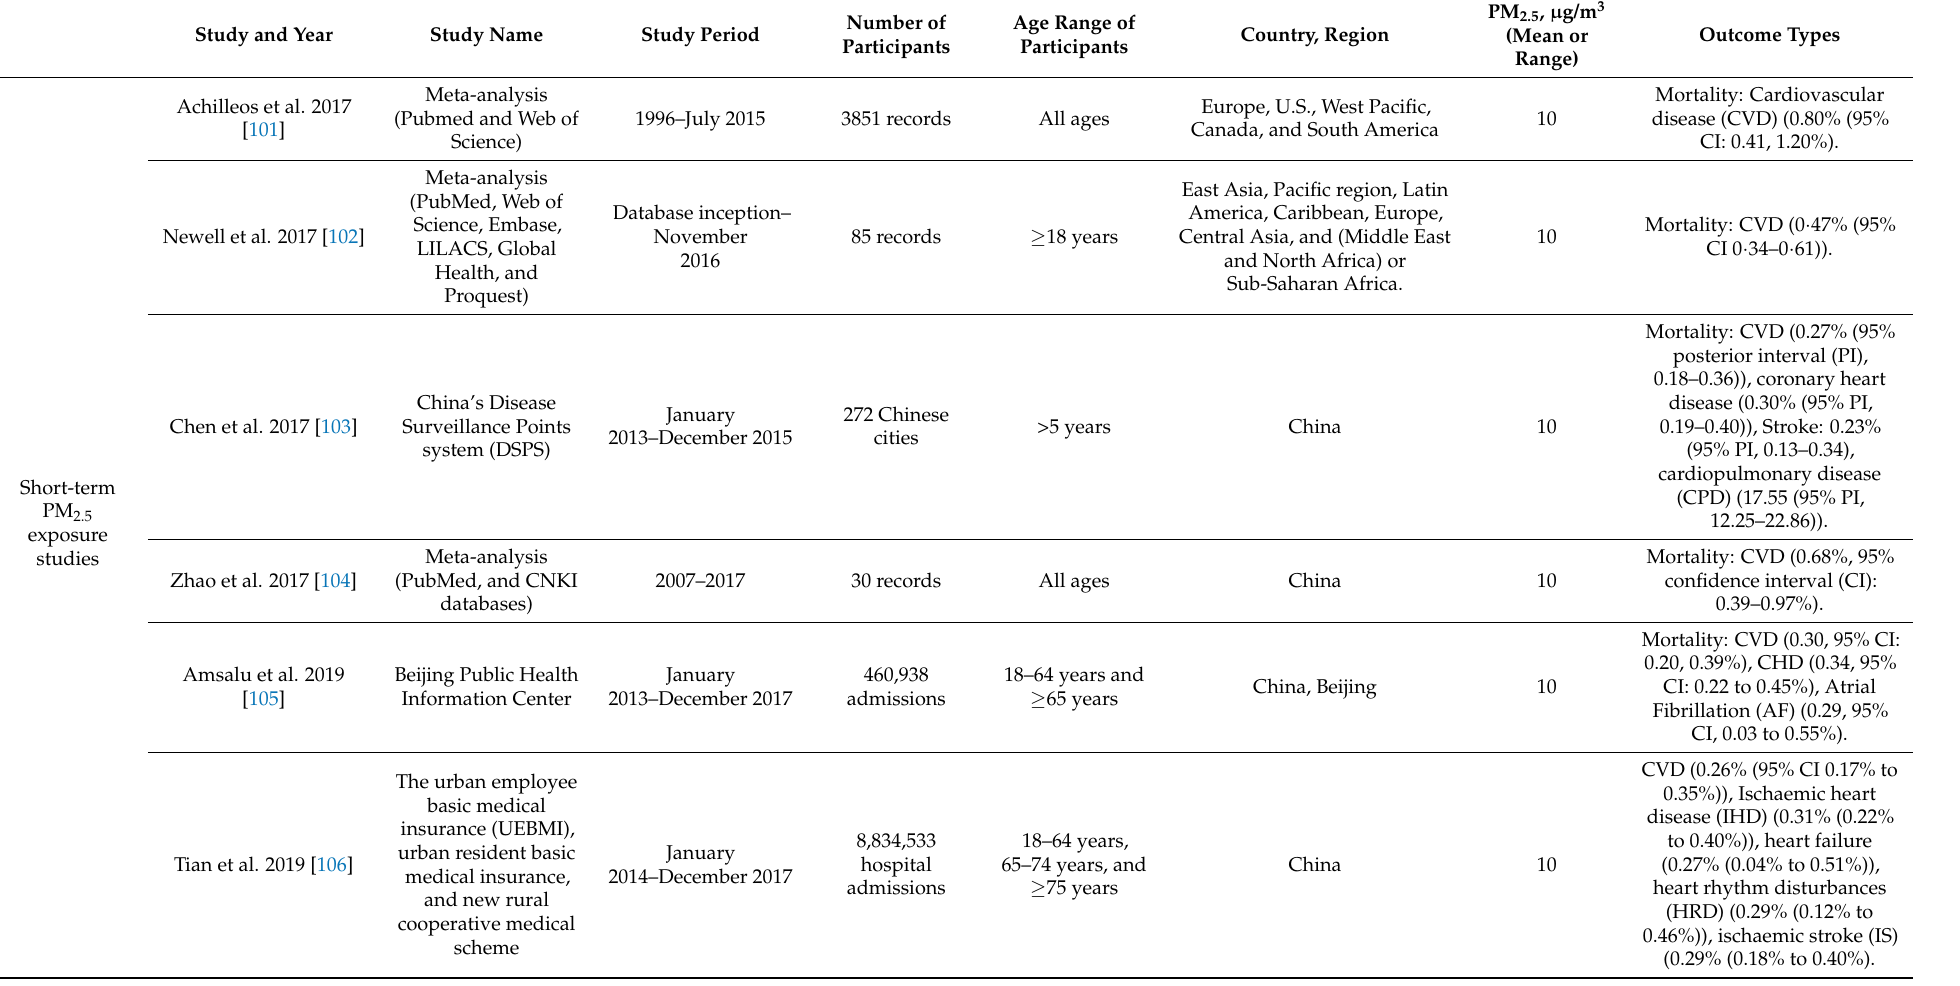
Table 2. Epidemiological studies published in the last five years (2017–2021) investigating the effects of PM 2.5 on the cardiovascular